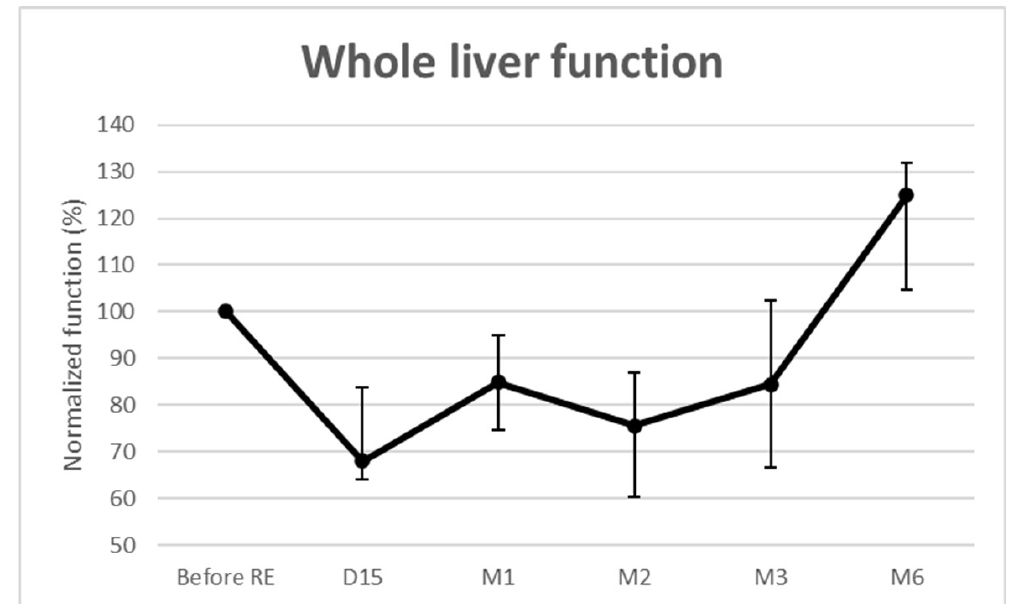
Figure 2. Functional changes from baseline of the whole livers.